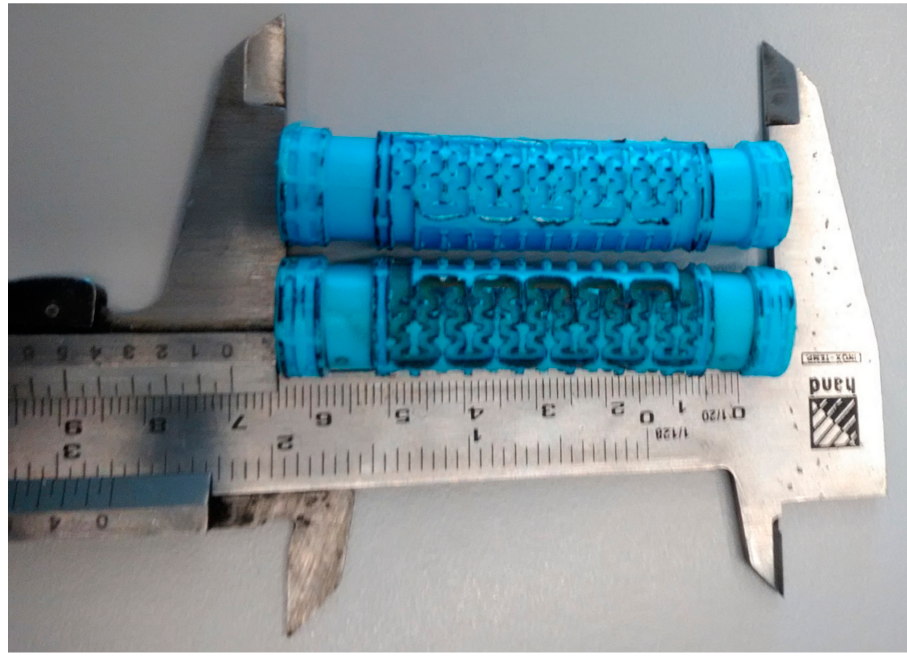
Figure 6. Serpentine inspection of the control (tap water; above) vs. 50 % diluted hydrocyclone filtered digestate liquid fraction (below)